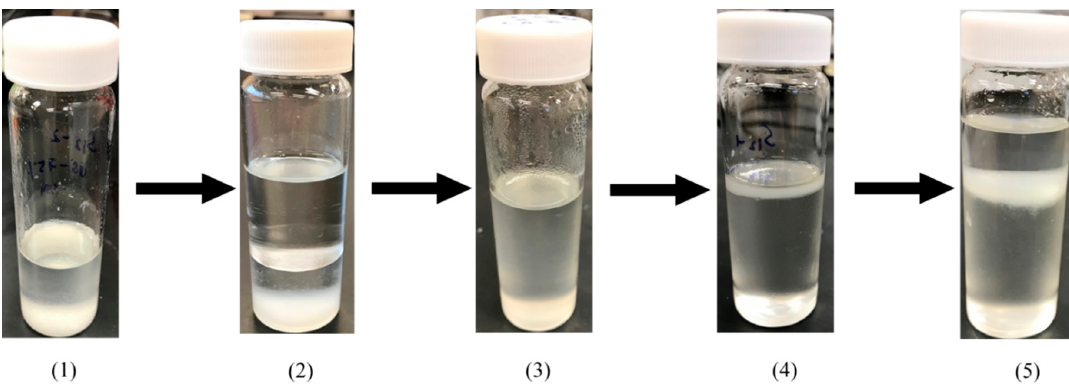
Figure 2. Extraction of lipids from dairy byproducts with N,N-dimethylcyclohexylamine (CyNMe2) as a switchable hydrophilicity solvent (SHS): ( 1 ) SHS with dairy sample after 18 h of extraction; ( 2 ) addition of water; ( 3 ) after bubbling CO 2 to separate the lipid phase; ( 4 ) lipids on the top and CyNMe2 on the bottom; and ( 5 ) addition of hexane to facilitate the separation of lipids.